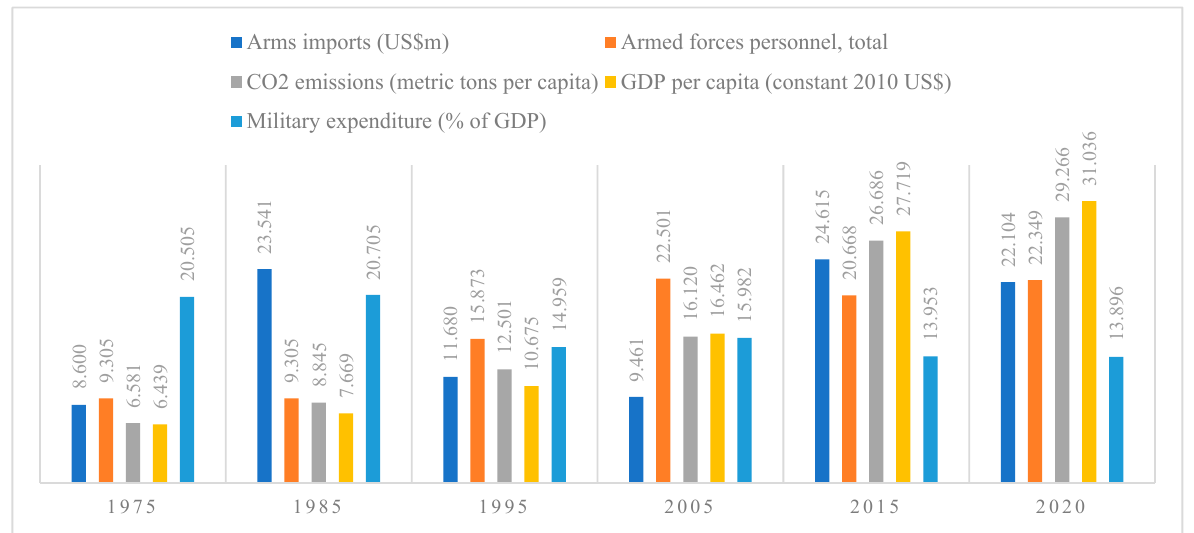
Figure 1. Trend analysis of arms transfers, carbon emissions, and India’s economic growth (annual percentage growth). Source: World Bank [6].